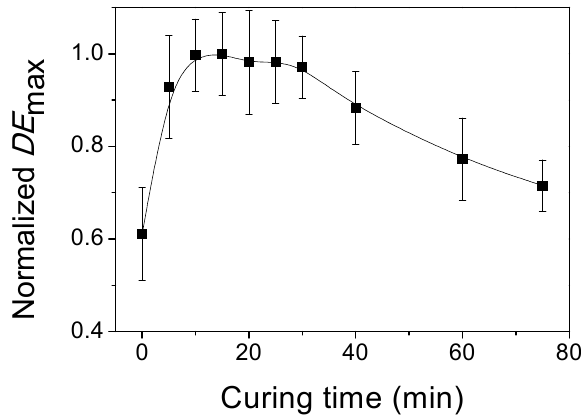
Figure 3. Normalized maximum diffraction efficiencies vs curing time for a photopolymer layer of d h = 150 ± 1 µm. H = 700 mJ/cm 2 was used in the recording stage. Error is ±1 min in the curing time.